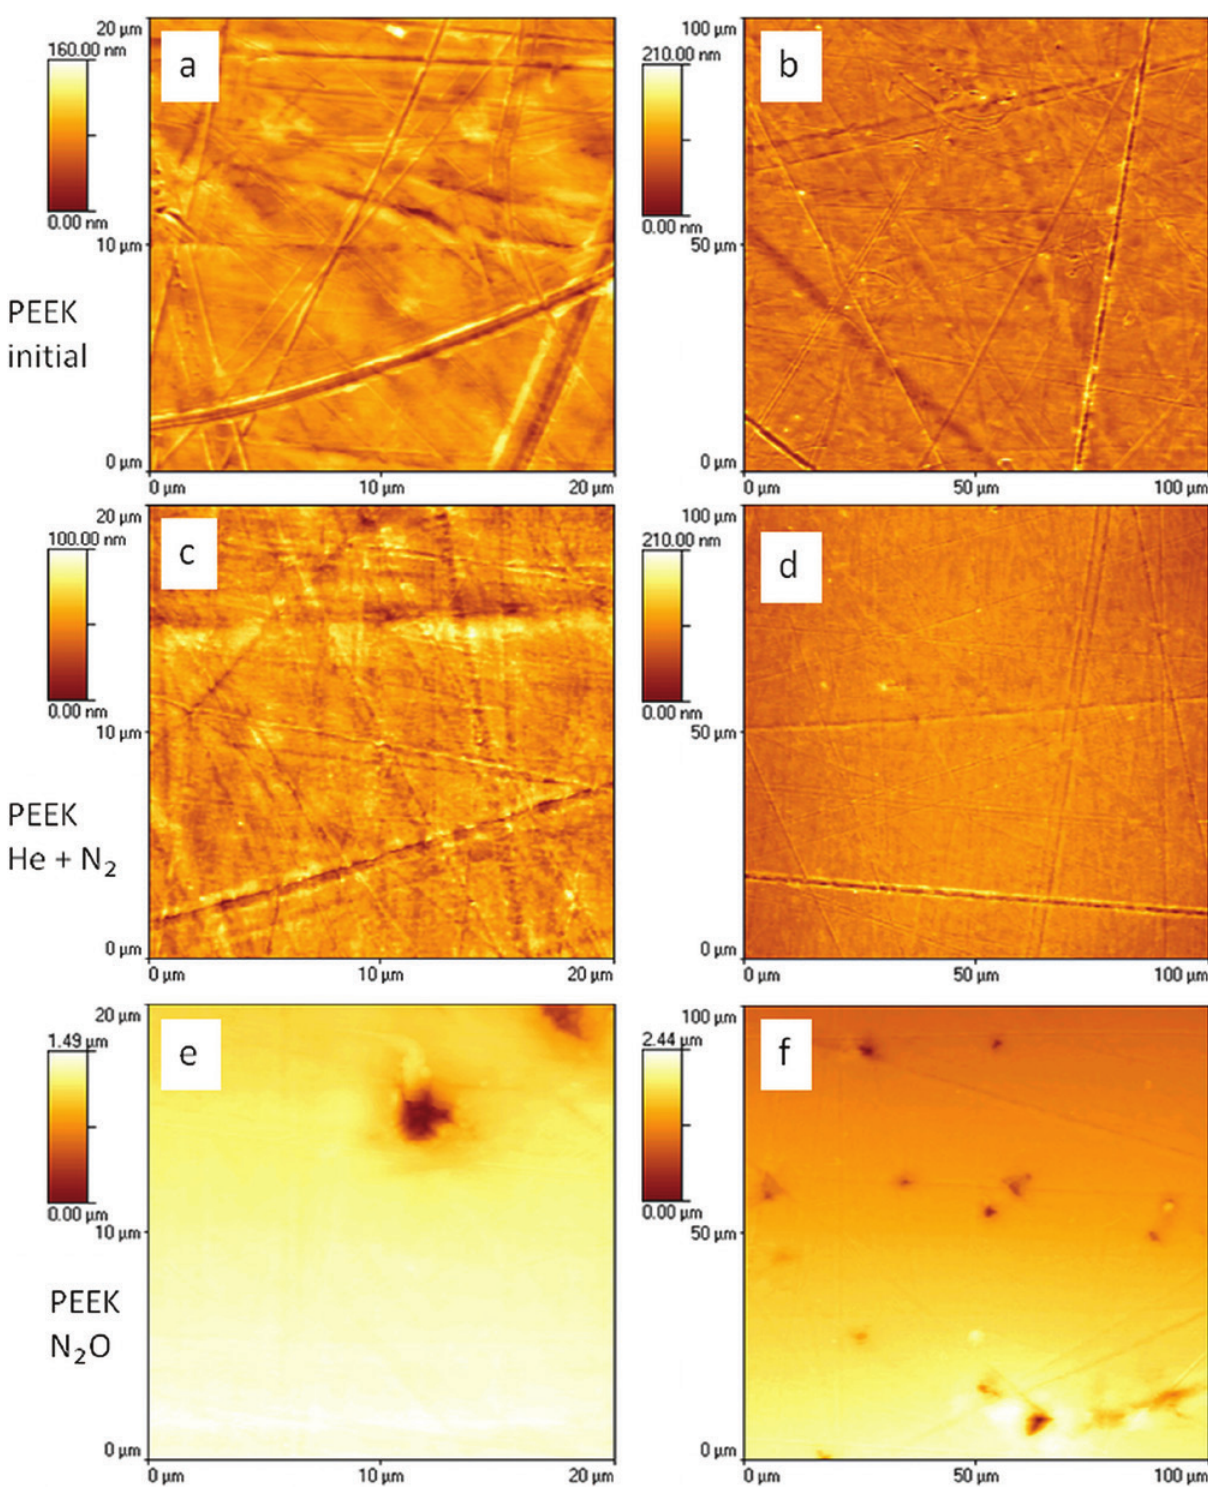
Fig. 1: AFM pictures of PEEK without modification (a, b), PEEK modified in He+N 2 atmosphere (c, d) and PEEK modified in N 2 O (e, f); scan areas 20 µm × 20 µm (a, c, e) and 100 µm × 100 µm (b, d,